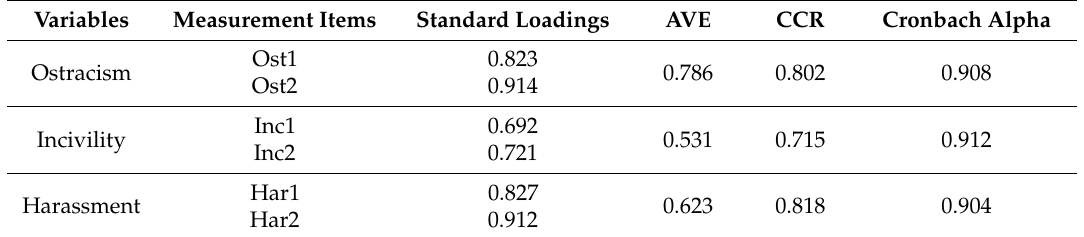
Table 1. Results of confirmatory factor analysis and Convergent validity and construct